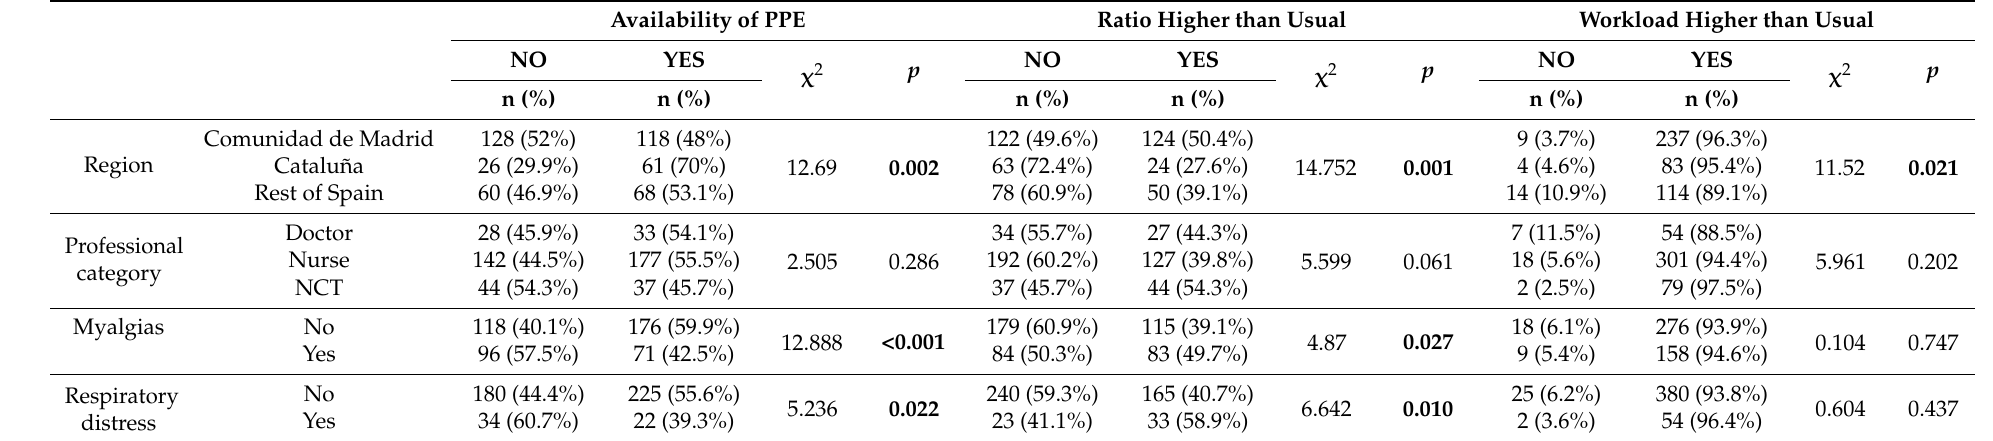
Table 5. Analysis of differences in clinical and occupational variables as a function of perceived PPE availability, patient/professional ratio and workload during the